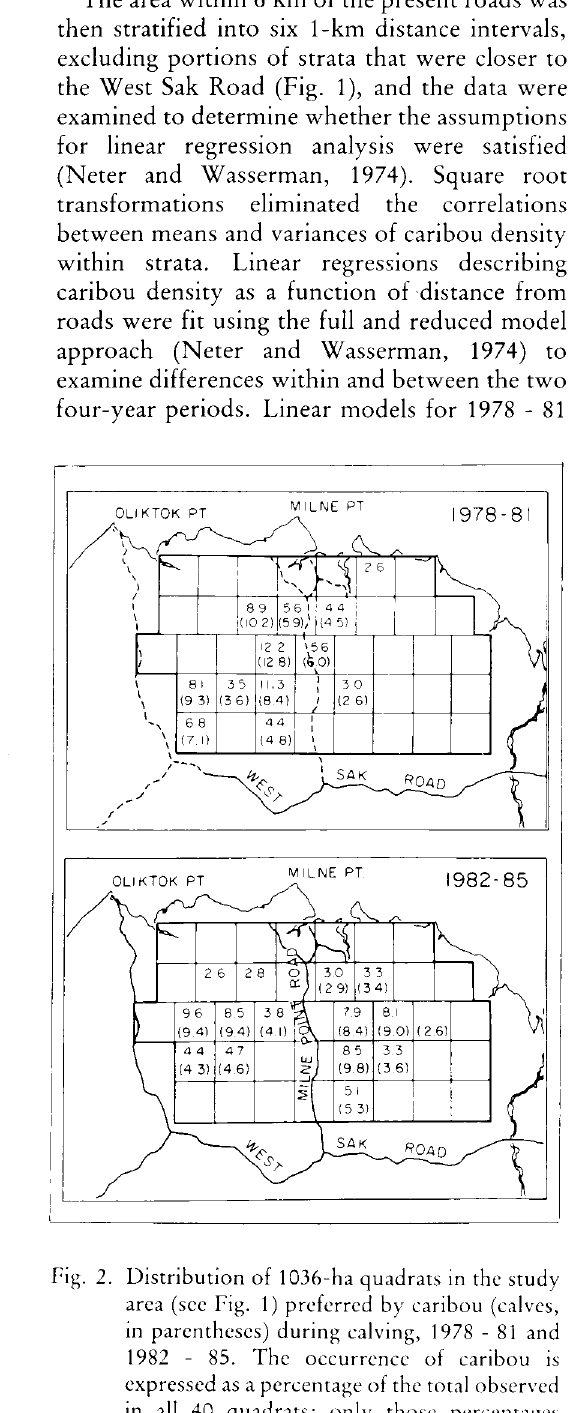
Fig. 2. Distribution of 1036-ha quadrats in the study area (see Fig. 1) preferred by caribou (calves, in parentheses) during calving, 1978 - 81 and 1982 - 85. The occurrence of caribou is expressed as a percentage of the total observed in all 40 quadrats; only those percentages exceeding 2.5% (the percentage of the total area for each quadrat) are